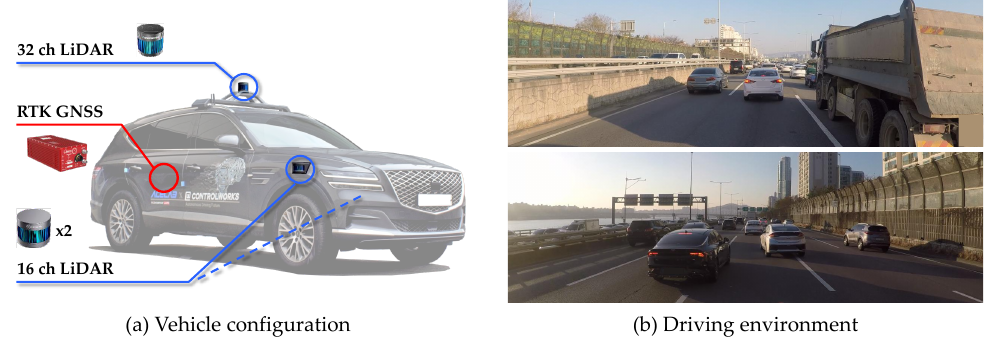
Figure 8. Experimental environment for real driving evaluation: ( a ) Test vehicle A1 equipped with one 32-channel LiDAR, two 16-channel LiDARs, and RTK-GNSS/INS; ( b ) test site including a congested